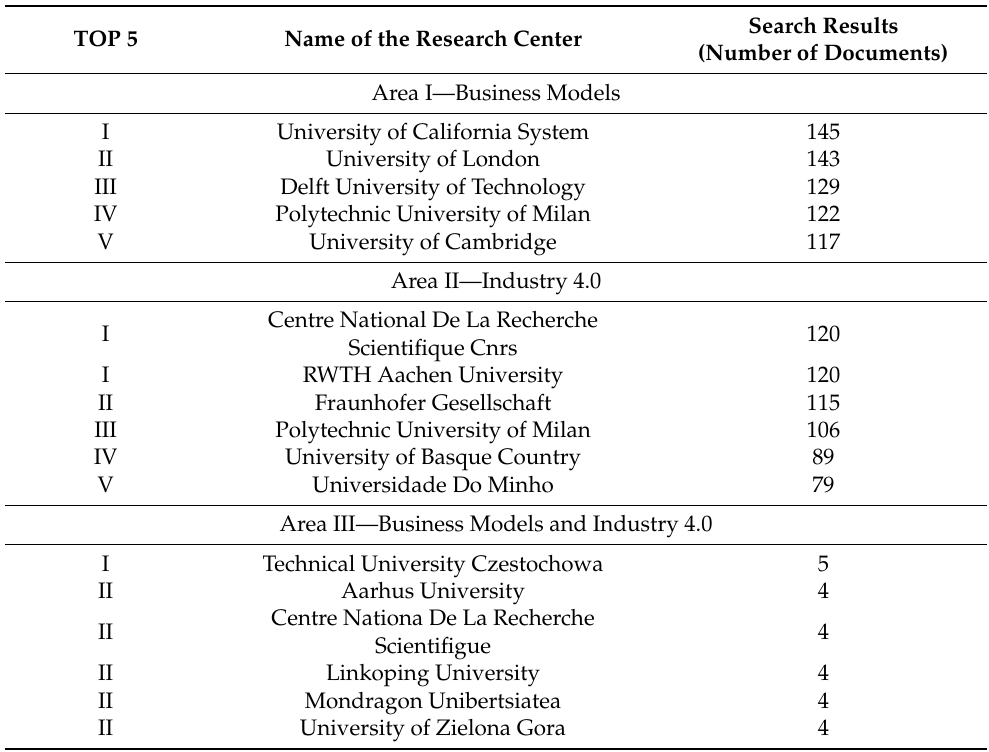
Table 3. Top 5 research centers (no less than 4